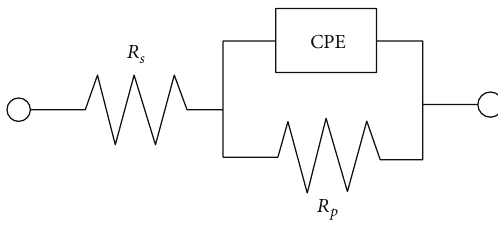
Figure 6: Equivalent circuit used to fit the EIS